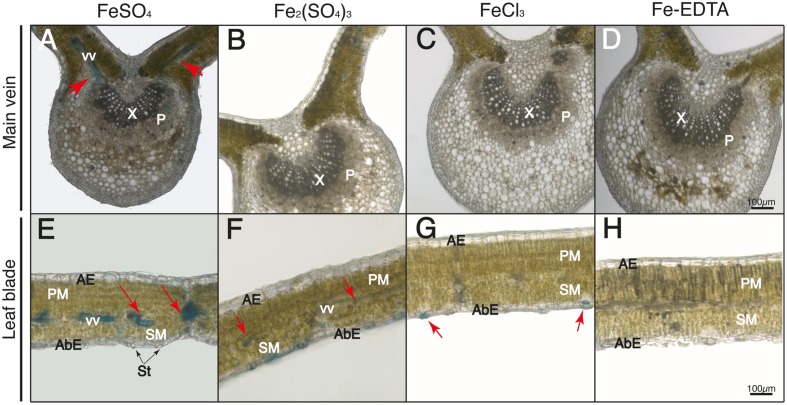
Localization of labile Fe pools using Perls blue staining in transversal leaf sections taken 24 h after Fe foliar fertilization: main vein (A–D) and leaf blades (E–H) Leaves were treated with FeSO4(A,E), Fe2(SO4)3(B,F), FeCl3(C,G), and Fe(III)-EDTA (D,H). Phloem and xylem tissues (P and X, respectively) and vascular vessels (VV) are marked in images (A–D); abaxial and adaxial epidermis (AbE and AE), parenchima and spongy mesophyll tissue (PM and SM), stomata (St) and vascular vessels (VV) are marked in images (E–H). Scale bars correspond to 100 μm.